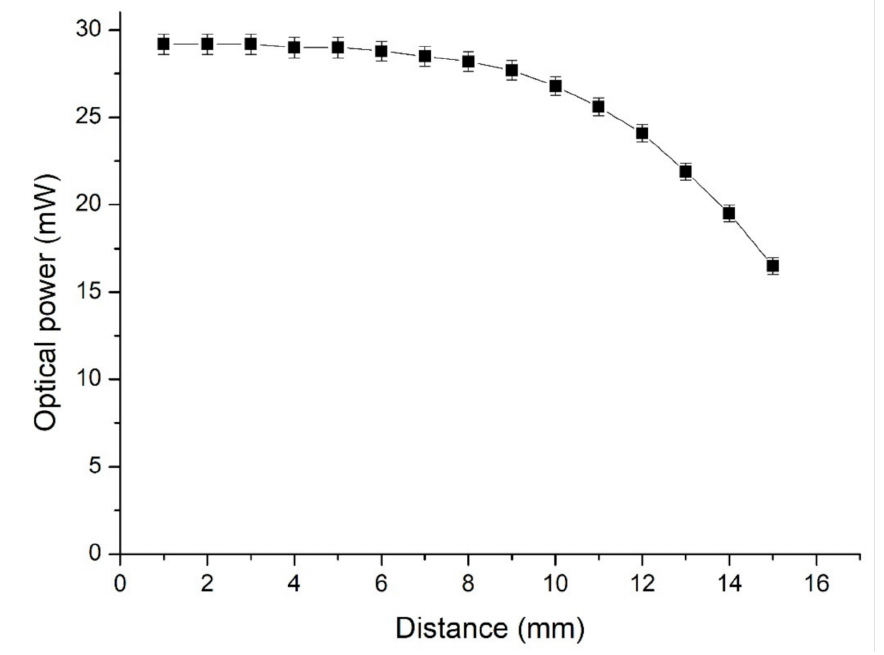
Figure 10. Optical power of the LED chip at various distances between the LED and the power